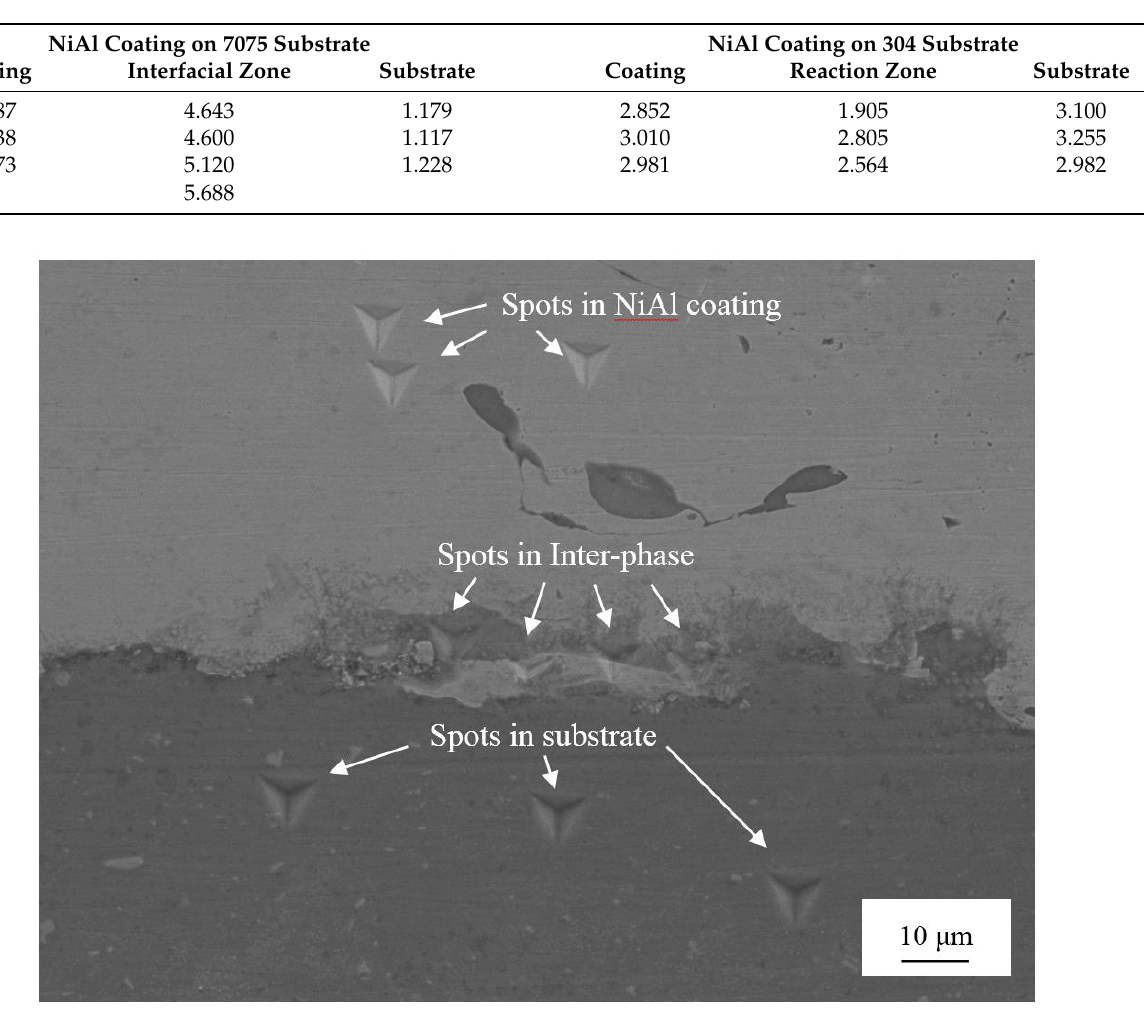
Figure 13. NiAl/304 interface: ( a ) Plasma wire sprayed NiAl coating on 304 substrate, ( b ) Magnified observation of the square zone of ( a ), ( c ) EDS line scan across the interface. Table 7. Compositions (wt. %) of points at NiAl/304 interface.